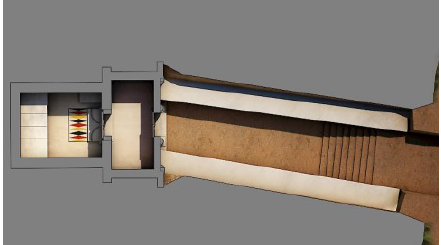
Figure 7: Floor plan of the tomb of Macridy